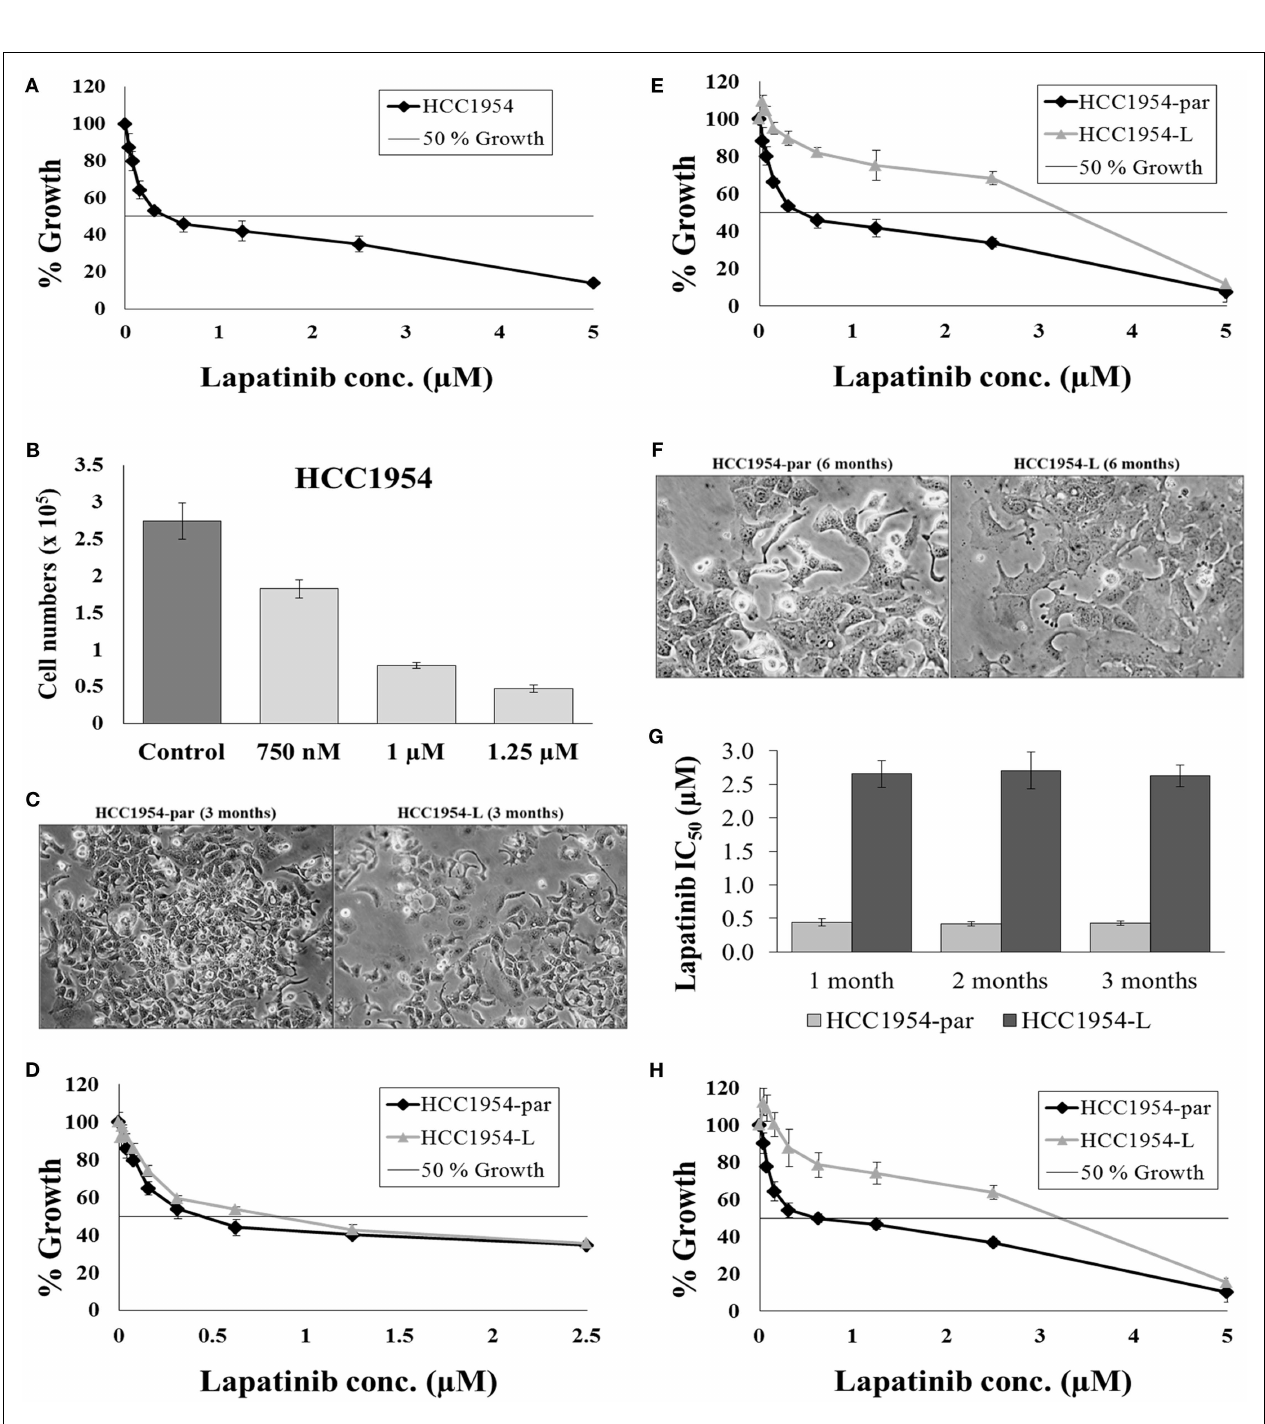
FIGURE 3 | Continuous selection of HCC1954 with lapatinib . (A) Proliferation of HCC1954 cells following a 5-day treatment with lapatinib. (B) HCC1954 cells treated with varying concentrations of lapatinib over a 4-day period. Cell counts were performed usingViaCount reagent and Guava Software and expressed relative to control untreated cells. (C) Images of HCC1954-par and HCC1954-L cells after 3months of lapatinib conditioning at 100 × magnification. (D) After 3months conditioning with 1 µ M lapatinib, the proliferation of HCC1954-par and HCC1954-L cells was measured. (E) After 6months conditioning with lapatinib, the proliferation of HCC1954-par and HCC1954-L was assessed.